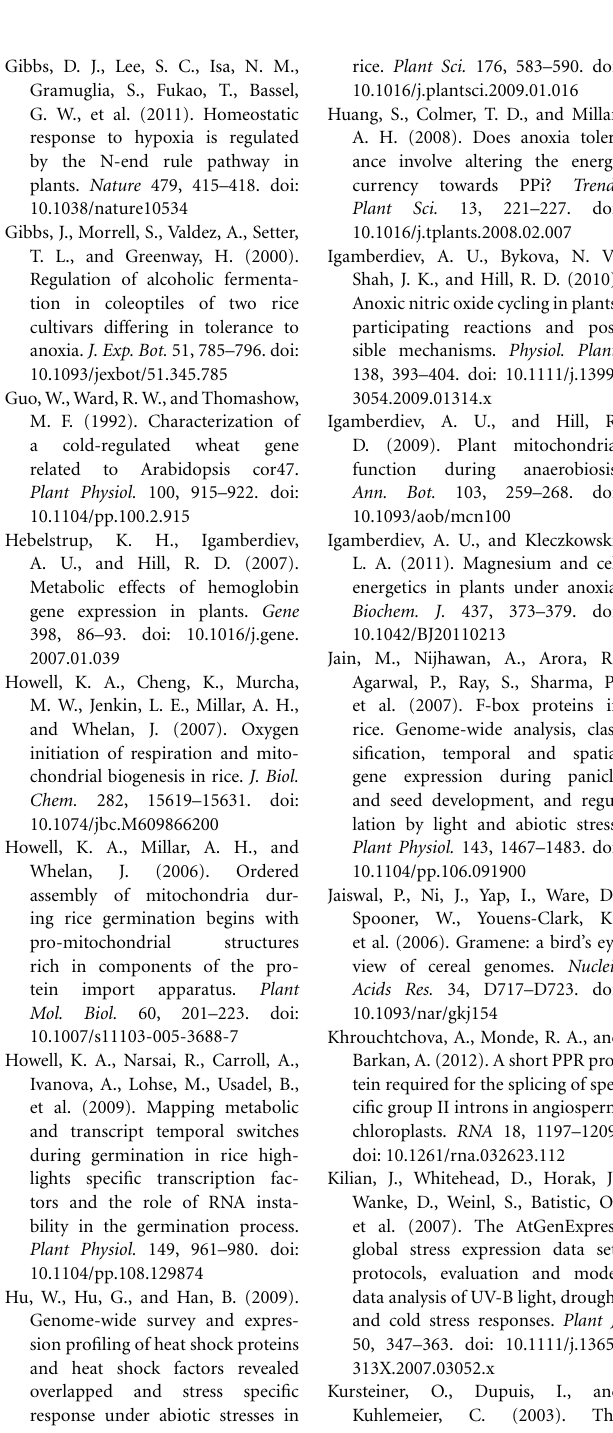
(i.e., FC = 2-fold, p < 0 . 05, PPDE > 0.96). Genes from these are shown in Figure 2 . Supplementary Table 6 | The low oxygen and abiotic stress comparisons and used for Arabidopsis from the sources outlined in Table 1. All microarrays for both species were GC-RMA normalized and analyzed in the same manner for differential expression using the Cyber-T method ( p < 0 . 05, PPDE >